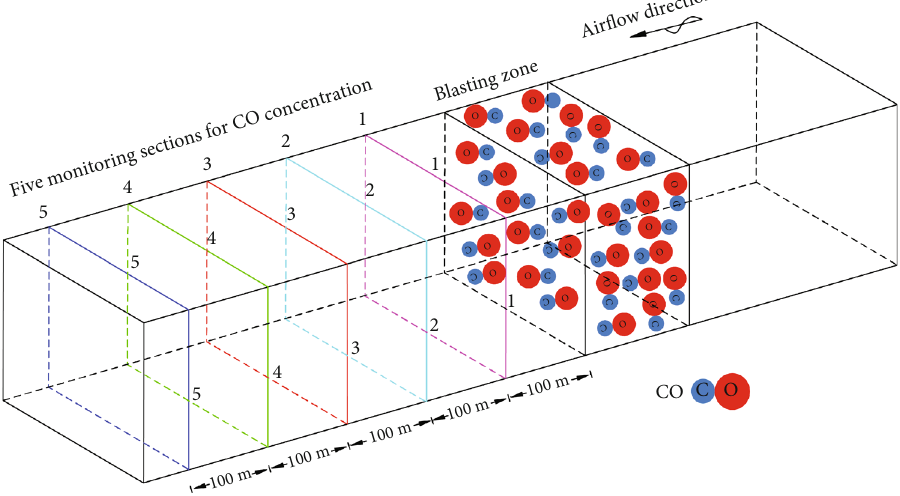
Figure 10: Monitoring sections of CO concentration in lane 9-2042: 1 – 100m from blasting zone, 2 – 200 m from blasting zone, 3 – 300 m from blasting zone, 4 – 400m from blasting zone, and 5 – 500m from blasting zone.